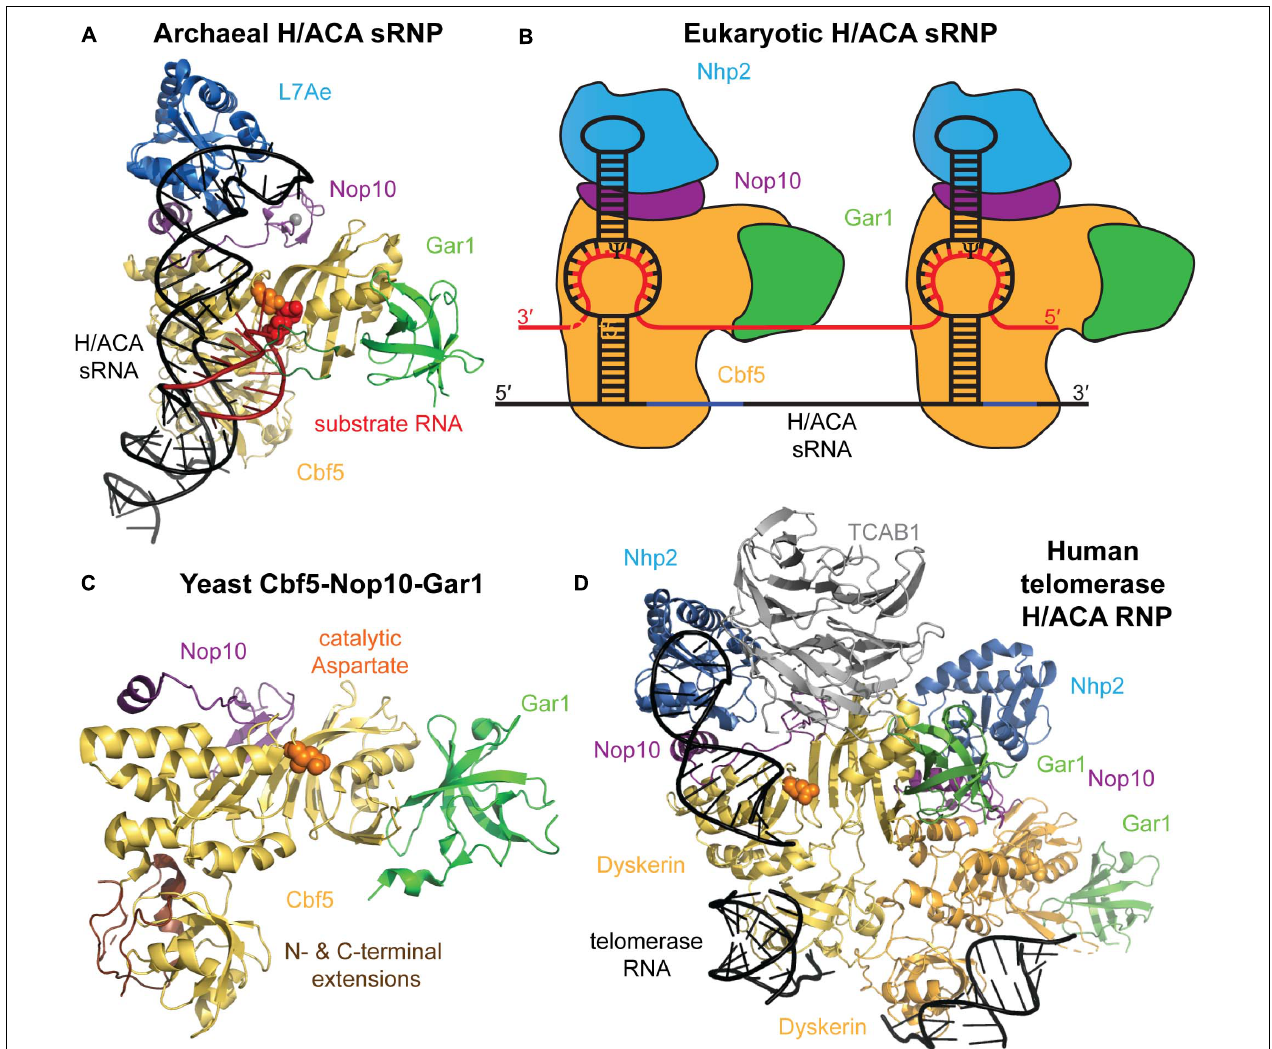
FIGURE 2 | Archaeal and eukaryotic H/ACA sRNP structure. (A) Crystal structure of an H/ACA sRNP bound to substrate RNA (red) from P. furiosus (PDB ID: 3HAY) (Duan et al., 2009). The single-hairpin H/ACA sRNA (black) binds to the four H/ACA proteins: Cbf5 (orange), Nop10 (purple), L7Ae (light blue), and Gar1 (green). In the active site of Cbf5, the catalytic aspartate residue is depicted in orange sphere adjacent to the target uridine (red sticks). (B) Schematic representation of the typical two-hairpin structure of a eukaryotic H/ACA sRNP bound to a target RNA (red). Each hairpin of the H/ACA snoRNA (black) is assumed to bind a complete set of H/ACA proteins. The proteins and RNAs are colored as in (A) . Note that Nhp2 is the eukaryotic homolog of archaeal L7Ae. (C) Crystal structure of the yeast Cbf5-Nop10-Gar1 complex (PDB ID: 3U28) shown in a similar conformation as the archaeal H/ACA sRNP complex in (A) (Li et al., 2011b). In eukaryotes, the PUA of Cbf5 (bottom) is larger than in archaea due to N- and C-terminal extensions shown in brown. (D) Structural model of the H/ACA sRNP complex assembled on the 3 (cid:48) end of human telomerase RNA based on a cryo-electron microscopy structure of human telomerase (Nguyen et al., 2018). Two sets of all H/ACA proteins